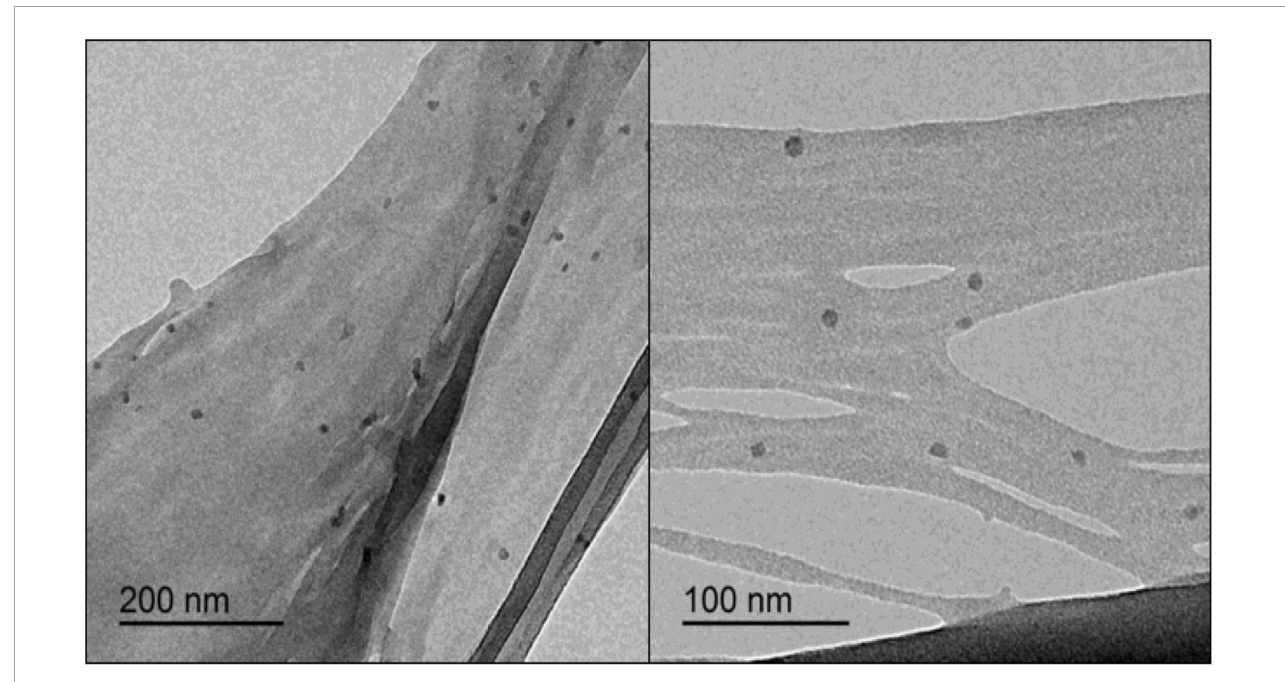
FIGURE10 TEM images showing CNCs with spherical shape obtained under optimal conditions of the MAE